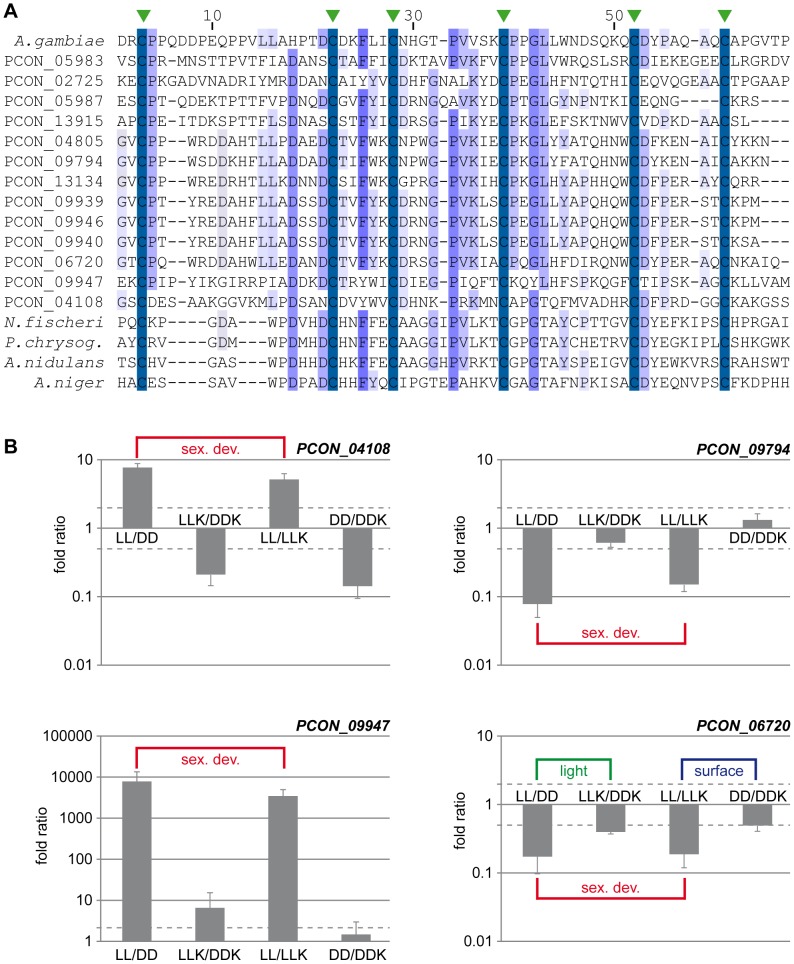
The CBM_14 domain protein family is expanded in P. confluens.
A. Multiple alignment of the CBM_14 domains of proteins from P. confluens, several Eurotiales and an insect. In addition to the P. confluens proteins, the following proteins were used for Clustal X analysis: A. gambiae, Anopheles gambiae sp|O76217.2; A. nidulans, Aspergillus nidulans ANID_00499 from the A. nidulans genome project http://www.broadinstitute.org/annotation/genome/aspergillus_group/MultiHome.html; A. niger, Aspergillus niger ref|XP_001397263.1; N. fischeri, Neosartorya fischeri ref|XP_001266454.1; P. chrysog., Penicillium chrysogenum ref|XP_002561001.1. The conserved cysteine residues are indicated by green arrowheads above the sequence. B. Quantitative real time PCR analysis of selected CBM_14 domain-encoding genes from P. confluens. Expression was analyzed for each gene in two independent biological replicates for the four conditions LL, DD, LLK and DDK (light and darkness in surface culture and submerged culture). Sexual development is only possible in condition LL. The graph shows mean and standard deviation (for better visualization, standard deviations for negative expression ratios are shown in the negative instead of the positive direction). Expression ratios were calculated to address the question if a gene is differentially regulated during sexual development (i.e. in LL/DD and in LL/LLK), or regulated by light (i.e. in LL/DD and LLK/DDK) or regulated by surface versus submerged growth (i.e. LL/LLK and DD/DDK).